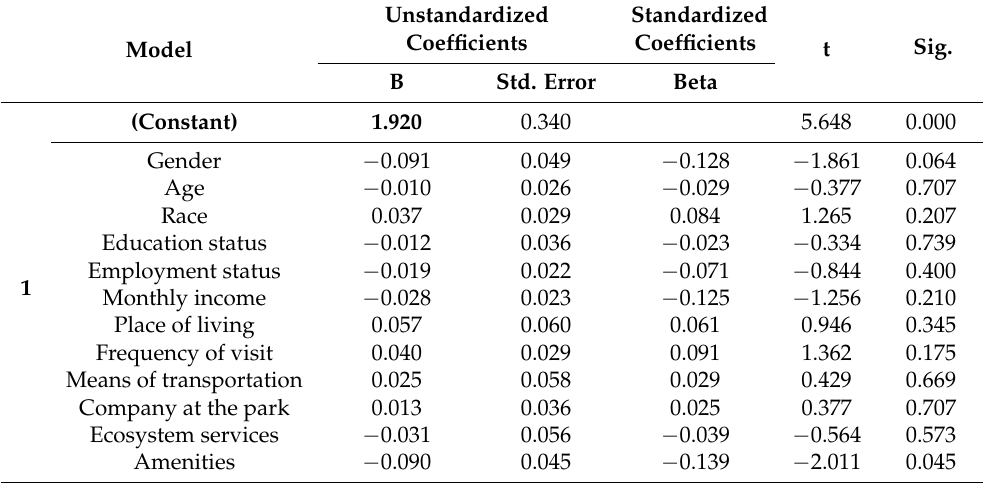
Table 10. Regression